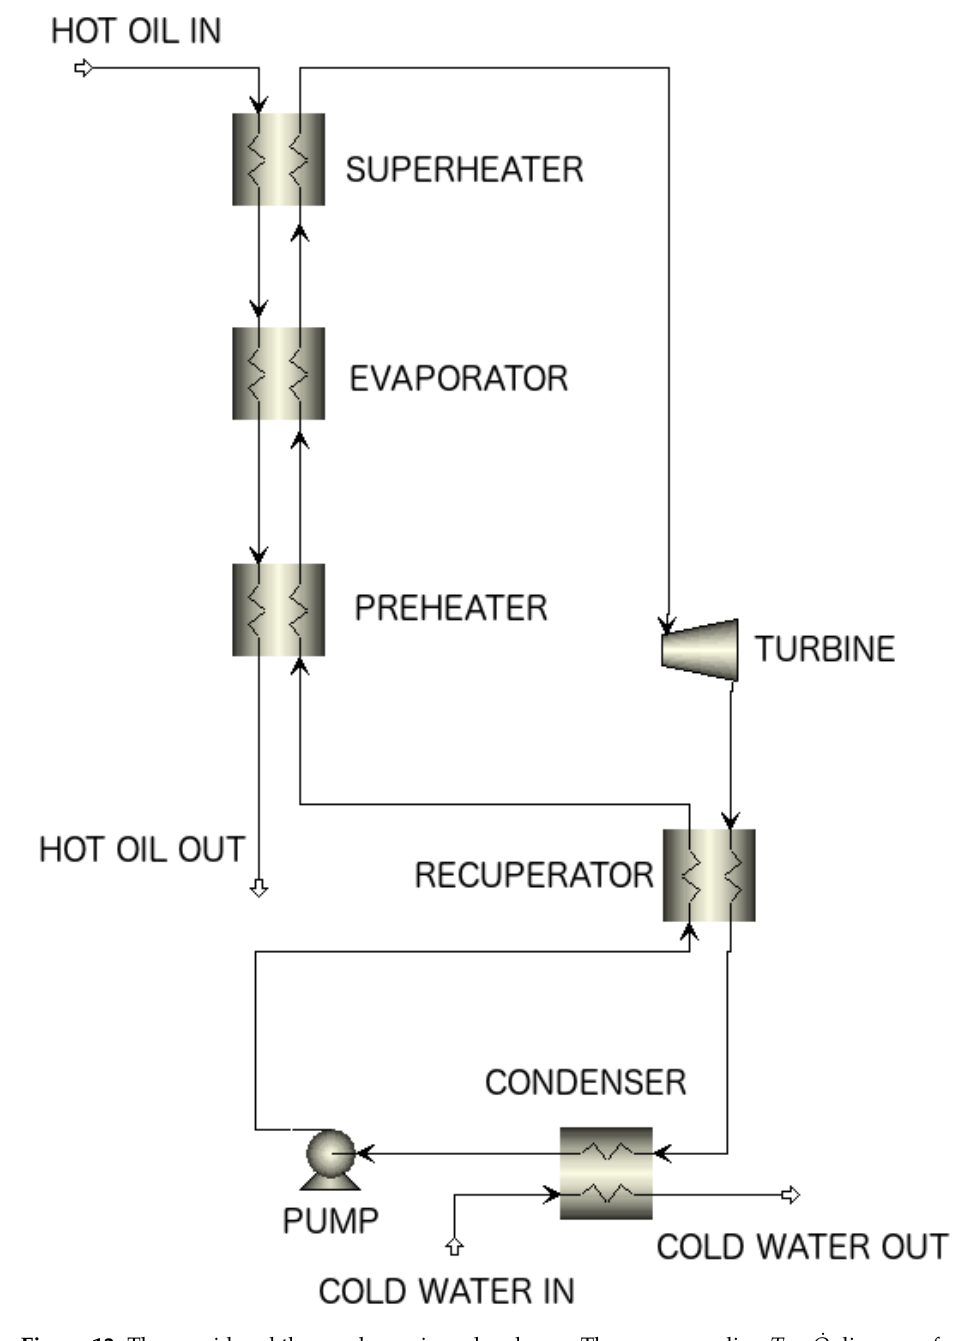
Figure 12. The considered thermodynamic cycle scheme. The corresponding T − ˙ Q diagrams for two cases are reported in Figure